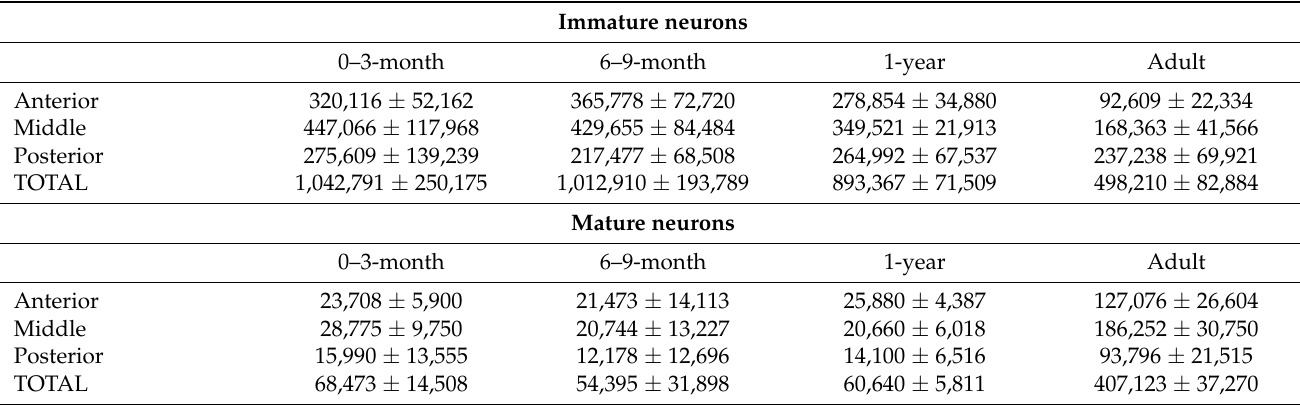
Figure 3. Distributions of immature ( a ) and mature ( b ) neurons in the paralaminar nucleus of the amygdala in 0–3-month-old ( n = 8; orange), 6–9-month-old ( n = 8; blue), and 1-year-old ( n = 4; red) control monkeys (average ± SD). Based on neuron number estimates reported in [9]. n.s., no statistically significant difference. Table 1. Neuron numbers in three anteroposterior segments of the paralaminar nucleus of the amygdala in control rhesus monkeys at different postnatal ages (mean ±